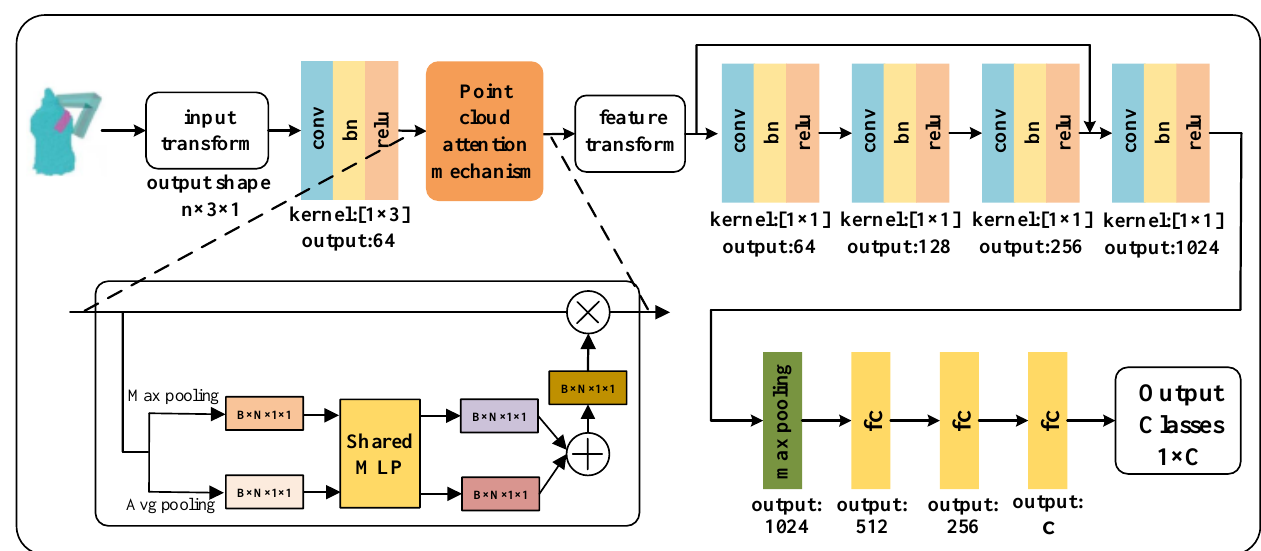
Figure 16. Overall structure of PointNet grasping quality classification network incorporating attention mechanism.